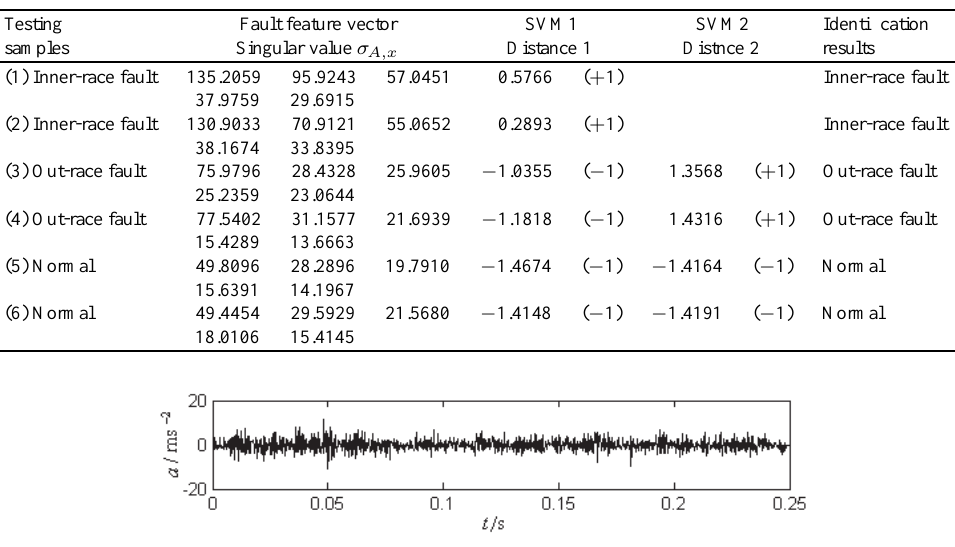
Table 3 The identification results of proposed method for roller bearing